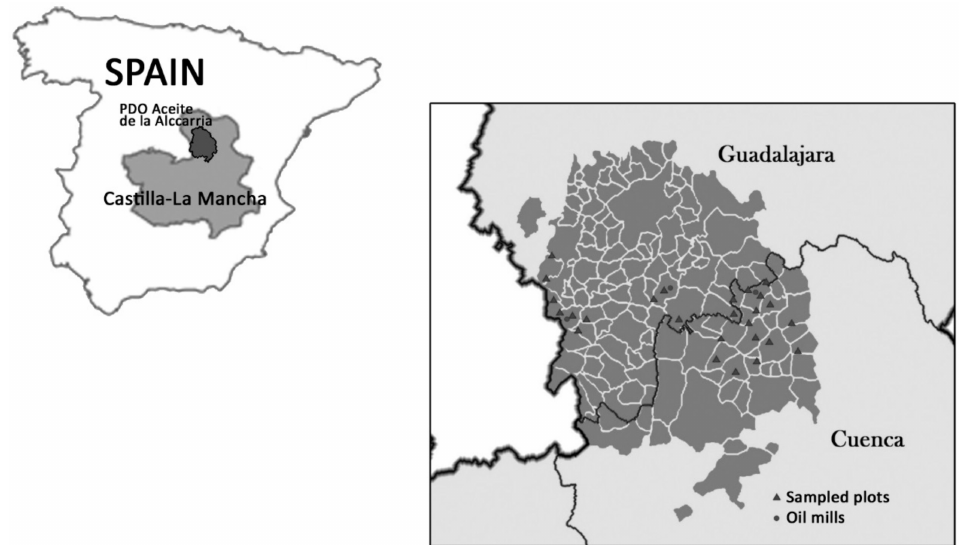
Figure 1. Location of sampled plots and oil mills within the area assigned to the protected designation of origin (PDO) Aceite de la